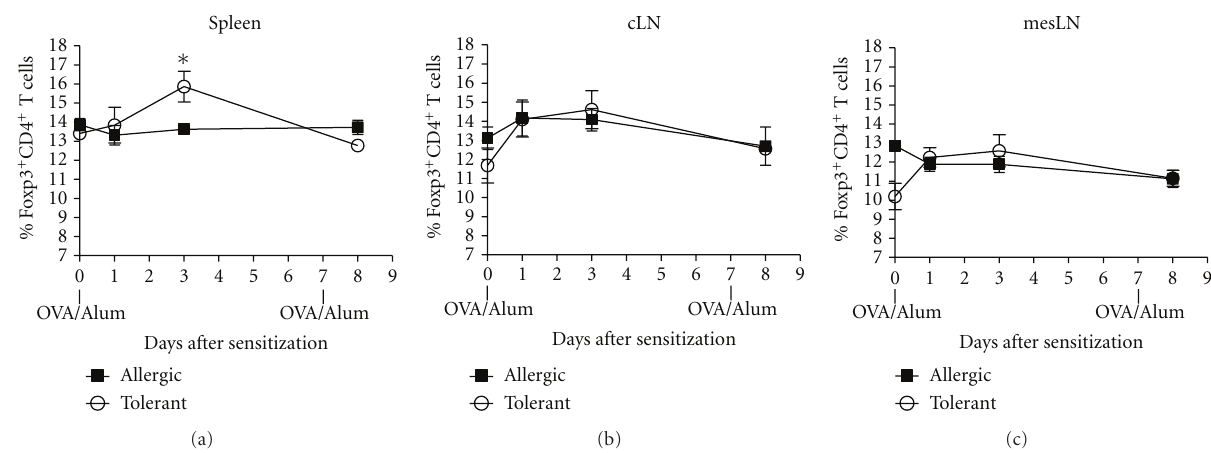
Figure 2: Regulatory T cells in lymphoid organs. Frequency of Foxp3 + CD4 + T cells in (a) spleen, (b) cervical lymph nodes (cLN), and (c) mesenteric lymph nodes (mesLN) of C57BL/6 fed or not with OVA before and after OVA/Alum sensitization. Cells recovered from the di ff erent lymphoid organs were stained for CD4 and Foxp3 and gated in CD4-positive cells. Values are representative of two independent experiments with pooled cells from three animals per